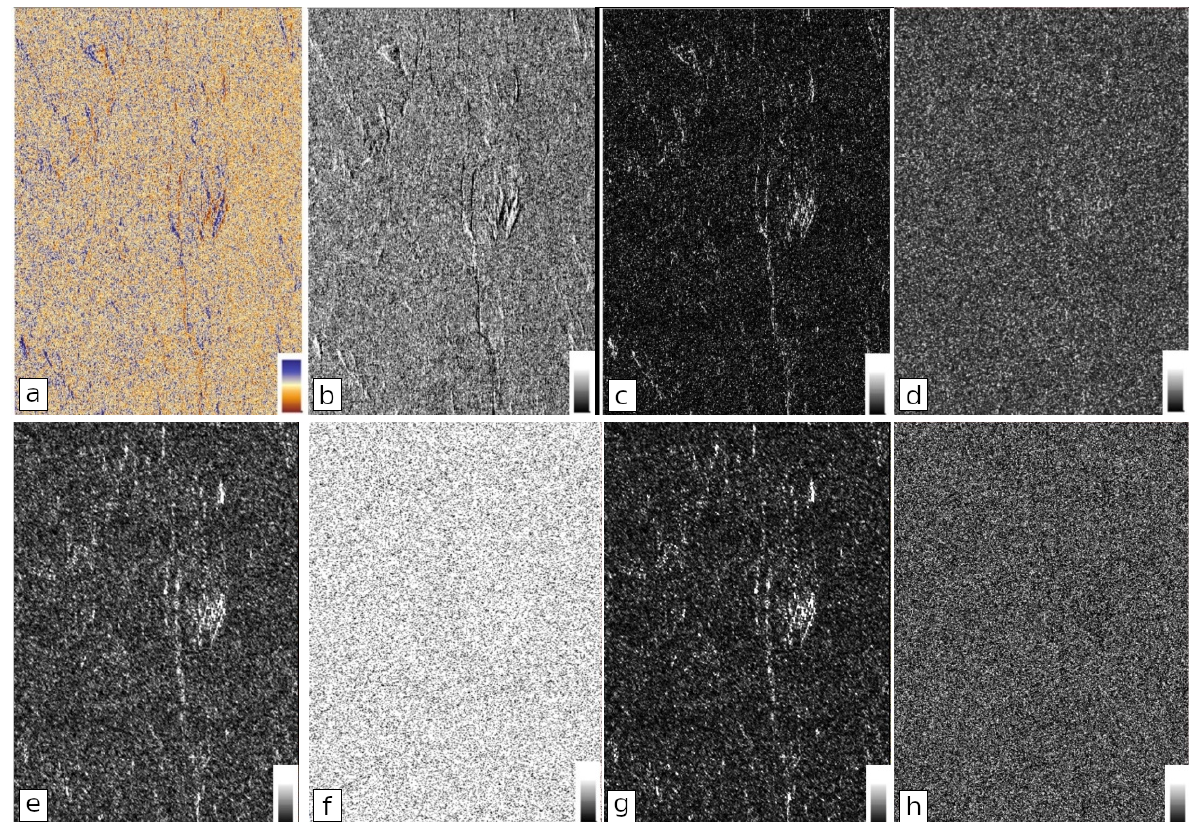
Figure 9. Results from the calculation of autocorrelation and texture indices. ( a ) original ASAR LR index image, and the spatial autocorrelation images generated based on ( b ) Getis-Ord’s Gi ∗ , ( c ) Moran’s I, and ( d ) Geary’s C. Texture indices are shown in ( e ) dissimilarity, ( f ) entropy (T, texture), ( g ) contrast, and ( h ) homogeneity images extracted from the original ASAR LR index